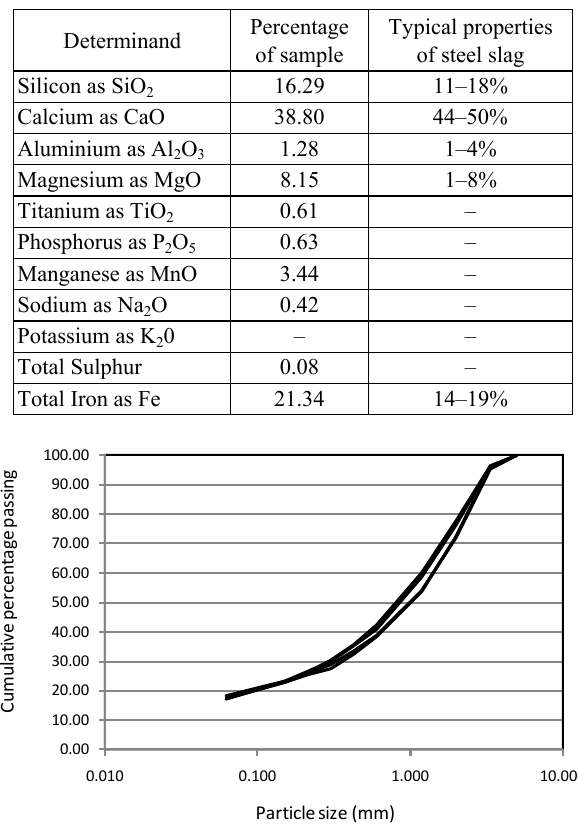
Table 1. Properties of BOS slag from Teesport (Jessic [5])